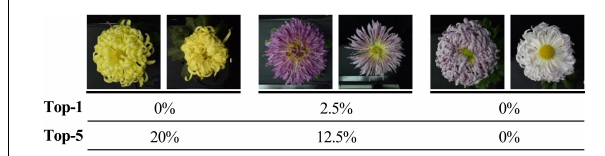
FIGURE 12 | Top-1 and Top-5 identification accuracy of some cultivars. Two adjacent images are the same cultivars from datasets in 2018 and 2019,